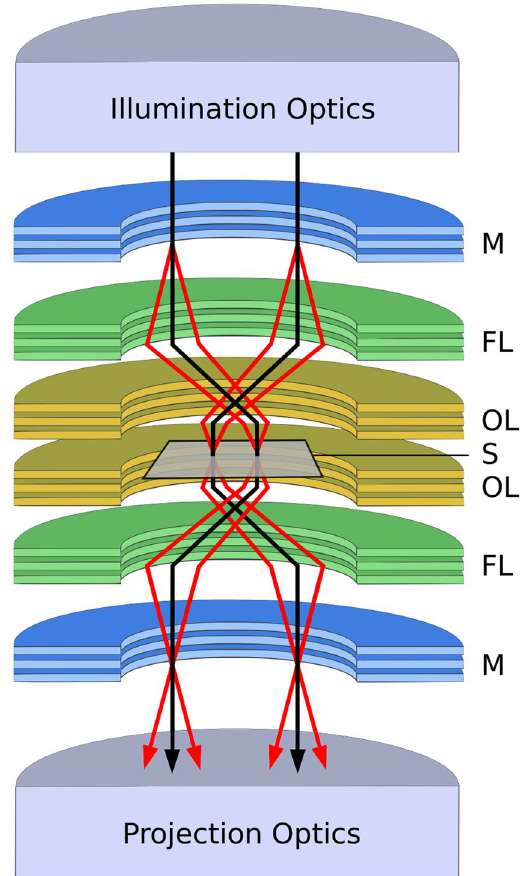
Figure 1. Schematic of multi-pass microscopy. A sample S is placed between two two objective and field lenses (OL and FL, respectively). This configuration is placed in between two mirrors M, which can be gated for in- and out-coupling of the electron beam (see methods). A pulsed probe beam is coupled into the optical path of the multi-pass microscope and illuminates S. The exit wave is subsequently re-imaged back onto the sample, which is now illuminated with an in-focus image of itself. This process is repeated multiple ( m ) times, after which the pulse is out-coupled and imaged onto a detector. For illustration, field (black) and imaging (red) rays are shown, which retrace themselves after one full